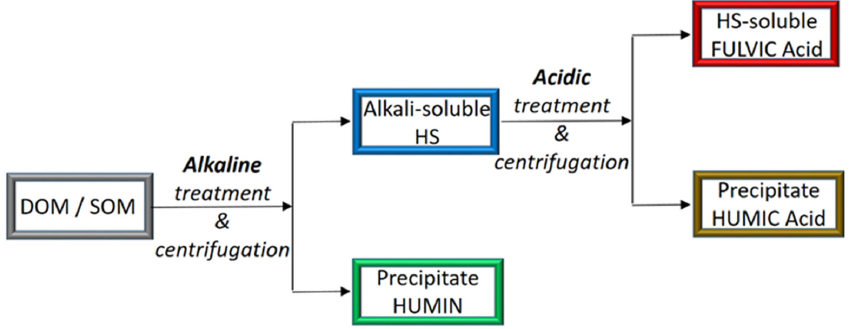
Figure 1. Generalized flowchart for the traditional extraction and fractionation procedure of HS